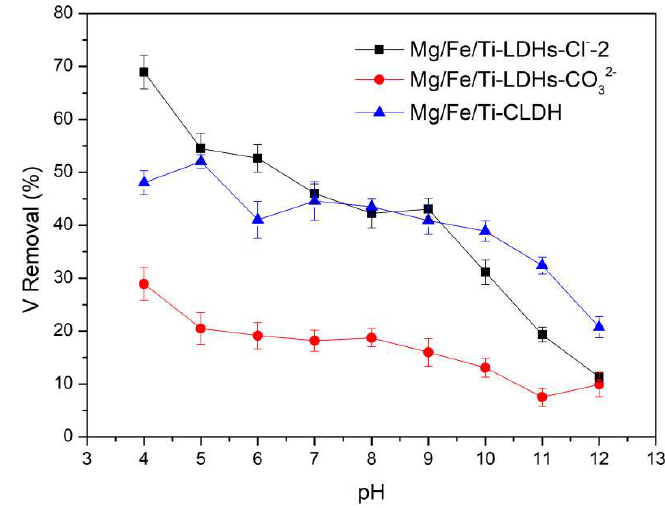
Figure 5. Effects of initial solution pH on vanadate adsorption onto Mg-Fe-Ti-LDHs-Cl − -2, Mg- Fe-Ti-LDHs-CO 3 2 − and Mg-Fe-Ti-CLDH (experimental conditions: C 0 = 10 mg/L, adsorbent dosage = 10 mg, pH = 4.0–12.0, contact time = 24 h, T = 298 K).